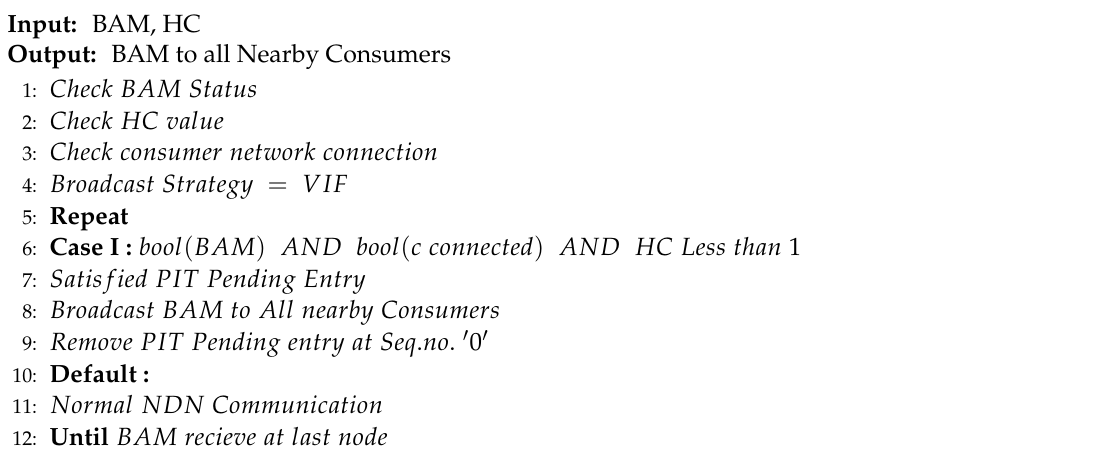
Algorithm 2 Proposed NDN Module for Consumer